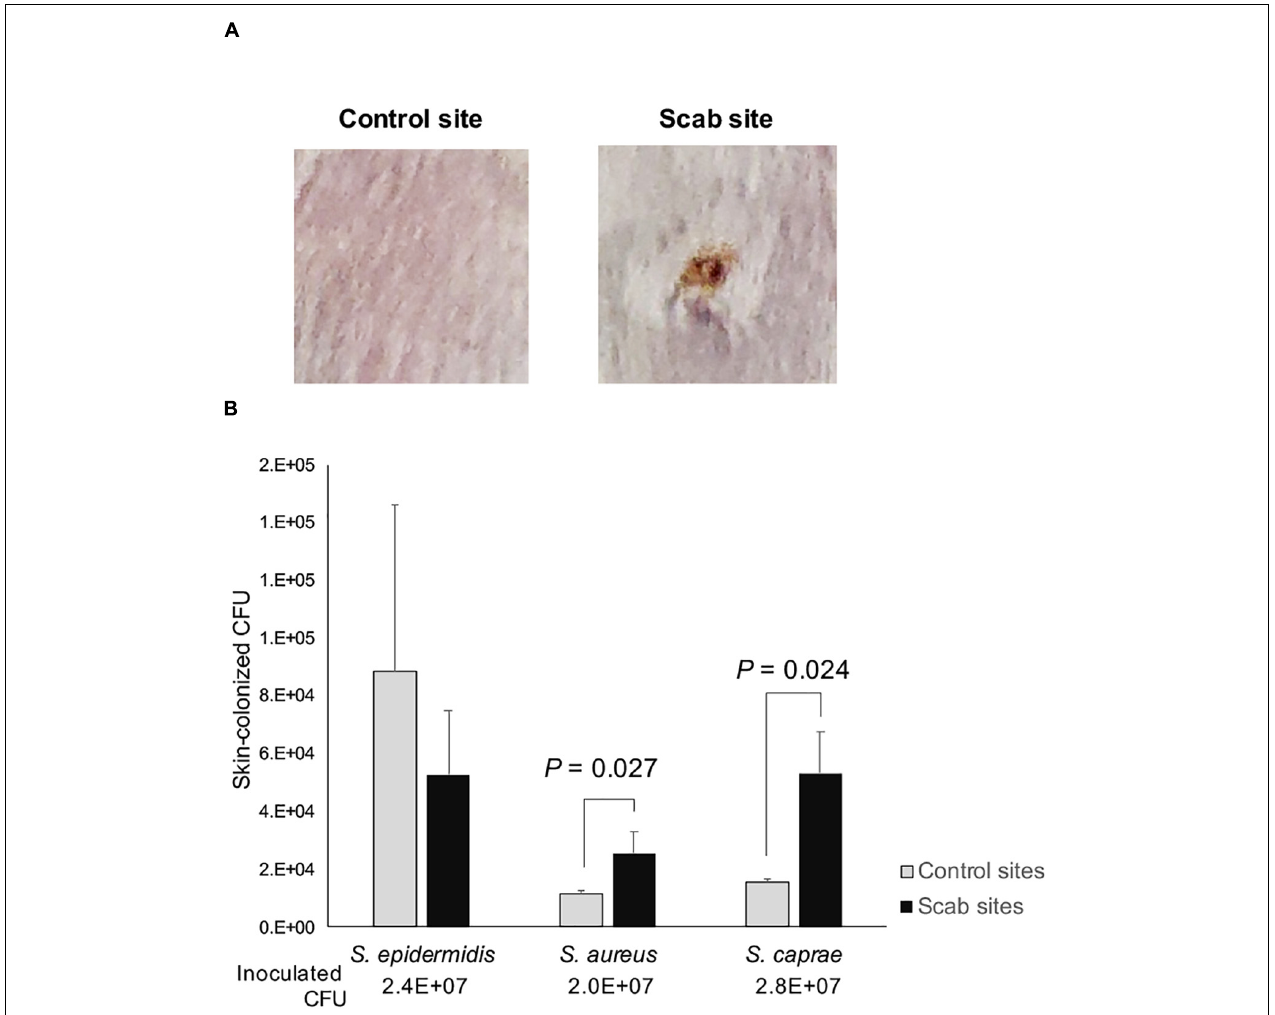
FIGURE 5 | Skin colonization of staphylococci. (A) Representative images of control and healed skin. To prepare skin healed from wounds, mouse skin was punched out, and wounds were left for 1 week. (B) Colonized bacteria. On Day 2 post-infection, skin (1 × 1 cm) was suspended in PBS and vigorously mixed by vortexing. The relative CFU values were calculated as (CFUs of colonized bacteria)/(CFUs of infected bacteria). p -Values were calculated by Student’s t